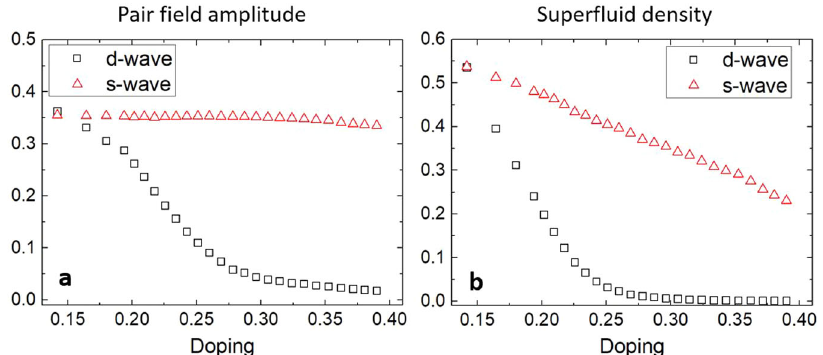
Fig. 4 The doping dependence of the spatial averaged zero-temperature magnitude of the pair fi eld and the mean- fi eld value of the super fl uid density. The band structures used in these plots are the same, the only difference is the pairing interaction. The red symbols represent s -wave pairing while the black symbols represent the d -wave pairing. In the band structures used in constructing these plots, the Fermi surface crosses van-Hove point, namely Lifshitz transition occurs, at the doping level p Lif ≈